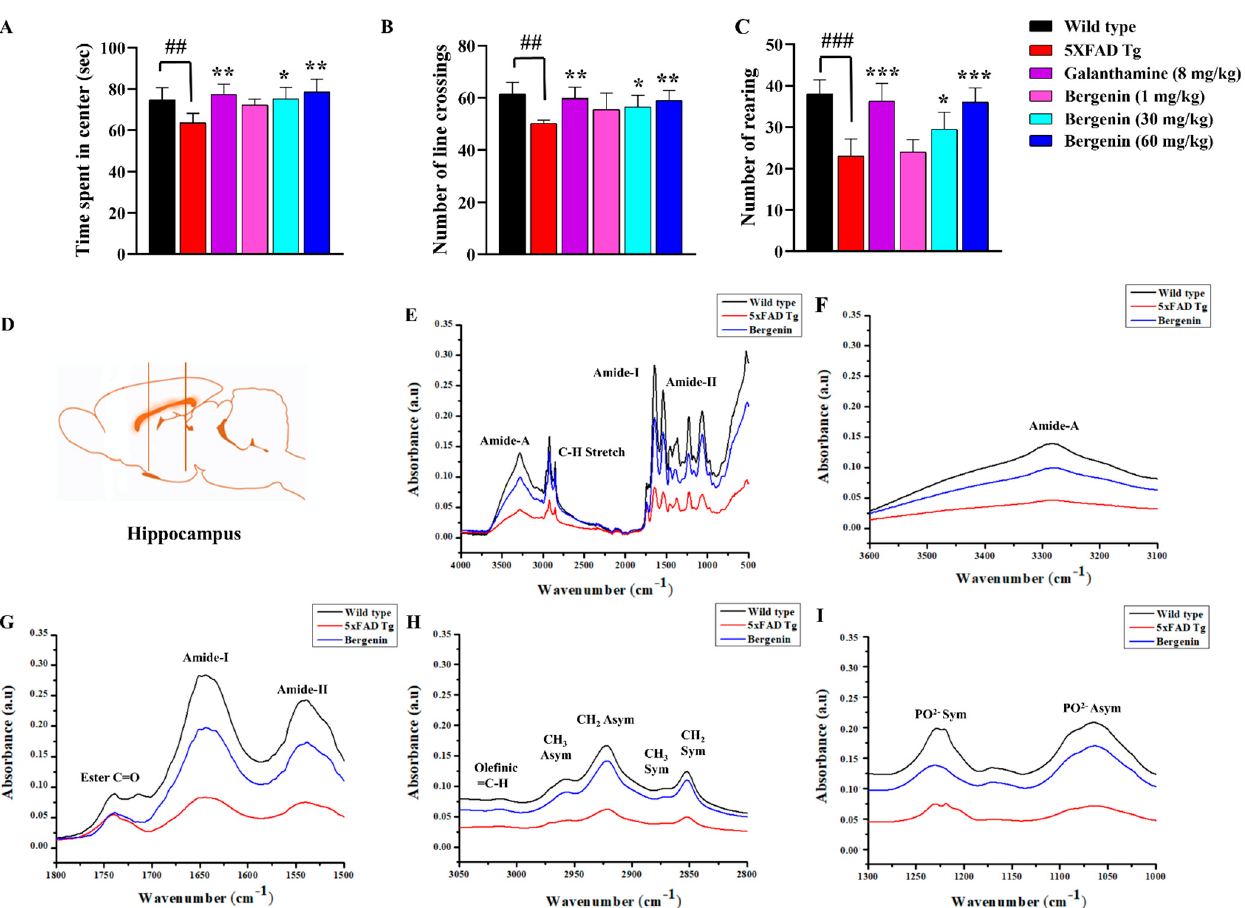
Figure 3. Bergenin attenuated anxiety-like behavior in 5xFAD Tg mice and exhibited no change in locomotor activity. ( A ) Time spent in center (s), ( B ) Number of line crossings, and ( C ) Number of rearing were evaluated in the open field test (OFT) for all the experimental groups. Results were expressed as mean ± S.D ( n = 10). * p < 0.05, ** p < 0.01 and *** p < 0.001 versus the 5xFAD Tg mice group, ## p < 0.01 and ### p < 0.001 versus the control (wild-type). ( D ) Diagrammatic representation of the hippocampal (HC) region in the mouse brain. FT-IR spectra of the HC region of mice brain in wild-type, 5xFAD Tg mice, and Bergenin groups in ( E ) 4000–500 cm − 1 (Full spectra), ( F ) 3600–3100 cm − 1 (Amide-A region), ( G ) 1800–1500 cm − 1 (Ester C=O, Amide-I, and Amide-II region), ( H ) 3050–2800 cm − 1 (olefinic =C-H, symmetric and asymmetric CH3, and CH2 regions), and ( I ) 1300–1000 cm − 1 (symmetric and asymmetric PO2- region).